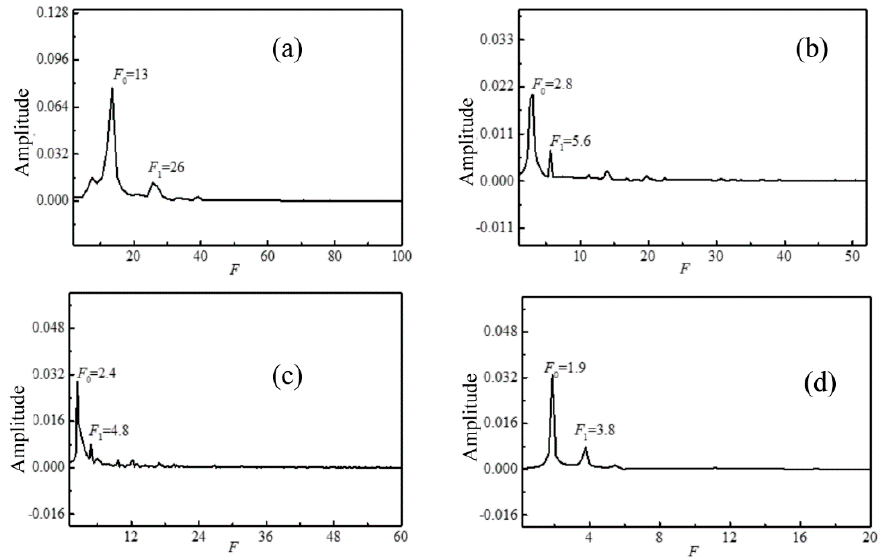
Figure 10. Fourier spectra analysis of the concentration oscillation at a surface monitor point P ( R = 0.55) when Re T = 6.0 × 10 3 . ( a ) Re s = 234; ( b ) Re s = 468; ( c ) Re s = 701; ( d ) Re s = 935.